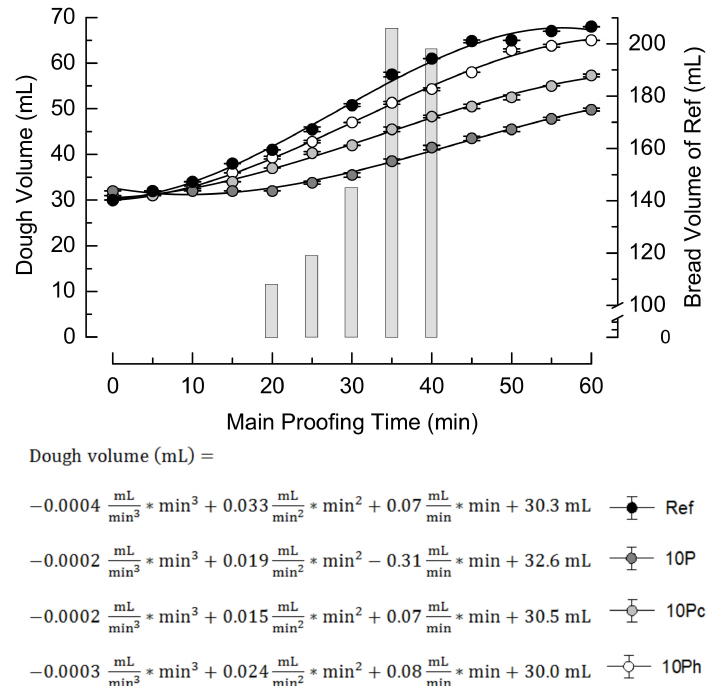
Figure 2. Increase in dough volume during main proofing (symbols and curves, n = 2) and volume of the reference bread baked after di ff erent main proofing periods (bars, n = 4). Ref, reference dough; 10P, dough based on 90% wheat flour and 10% pomace; 10Pc, similar to 10P but with pomace soaked in cold water; 10Ph, similar to 10P but with pomace soaked in boiling